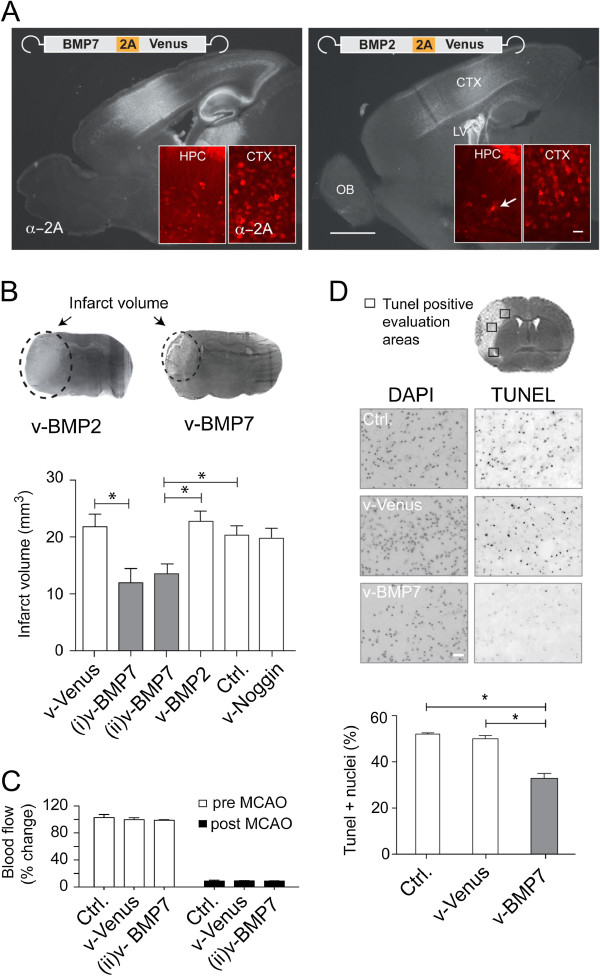
rAAV-transduced v-BMP7 decreases ischemic brain damage. A. Efficient, long-lasting v-BMP2 and v-BMP7 expression eight weeks after rAAV injection into the brains of neonatal mice. Fluorescent immunohistological images of sagittal brain sections are in gray scale. CTX, cortex; HPC, hippocampus; OB, olfactory bulb; LV, epithelium of lateral ventricles. Scale bar, 1 mm. Insets: confocal images of cortical neurons expressing v-BMP2 and v-BMP7. Cellular resolutions show neurons expressing v-BMP2 and v-BMP7 and one v-BMP2 positive astrocyte. Scale bar, 30 μm. B. Top: silver-stained coronal brain sections with marked, unstained infarcts 48 h after MCAO. Bottom: quantification of infarct volumes. The brain edema did not differ between groups. Values are means ± SEM. First experiment (i): v-Venus, n = 8; v-BMP7, n = 9; v-BMP2, n = 12; v-Noggin, n = 7); one-way ANOVA, P = 0.0049, *, p < 0.05 (Tukey’s posthoc test). Second experiment (ii): Ctrl., n = 4; v-Venus, n = 8; v-BMP7, n = 8; one-way ANOVA, P = 0.0265, *, p < 0.05 (Tukey’s posthoc test). C. Virally delivered v-BMP7 had no influence on cerebral blood flow measured by Doppler sonography before and after MCAO in (ii). Values were normalized to Ctrl. before MCAO; means ± SEM. D. The rAAV-expressed v-BMP7 reduced apoptosis after MCAO. Top: apoptotic nuclei were quantified 48 h after MCAO on TUNEL-stained coronal sections in indicated areas. Middle: images of TUNEL- and DAPI-stained (total number of nuclei) brain sections after MCAO in gray-scale. Scale bar, 50 μm. Bottom: quantification of apoptotic nuclei after MCAO was determined in relation to the total number of DAPI stained nuclei in all three indicated areas. Values are means ± SEM (n = 3). One-way ANOVA, P = 0.0002, *, p < 0.05 (Tukey’s posthoc test).